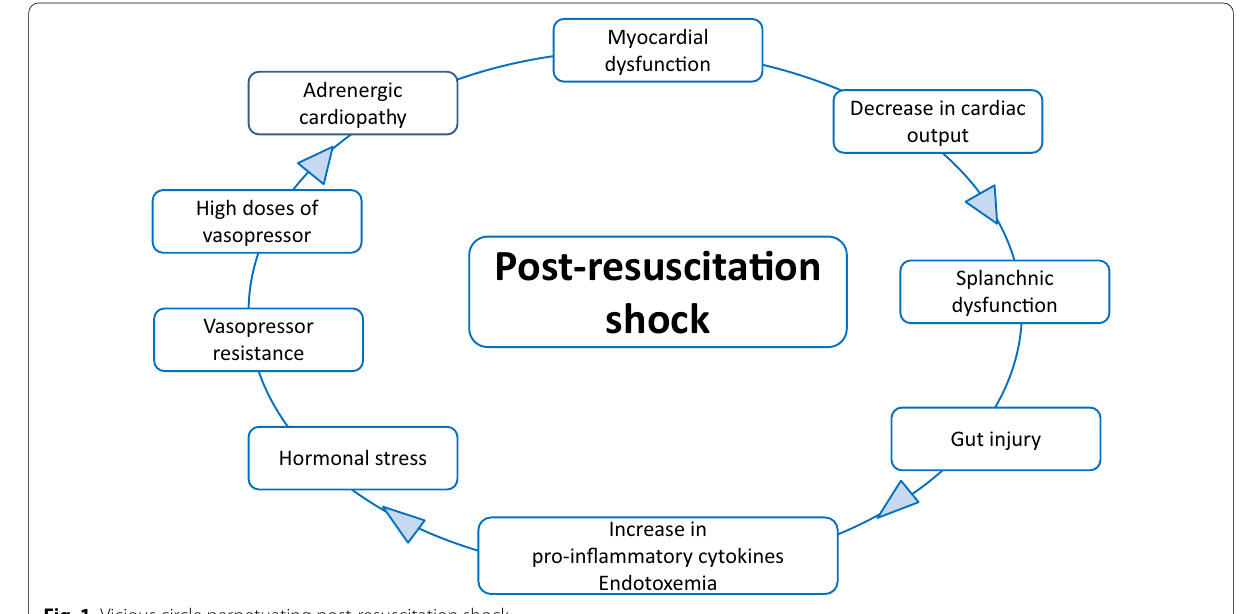
Fig. 1 Vicious circle perpetuating post-resuscitation